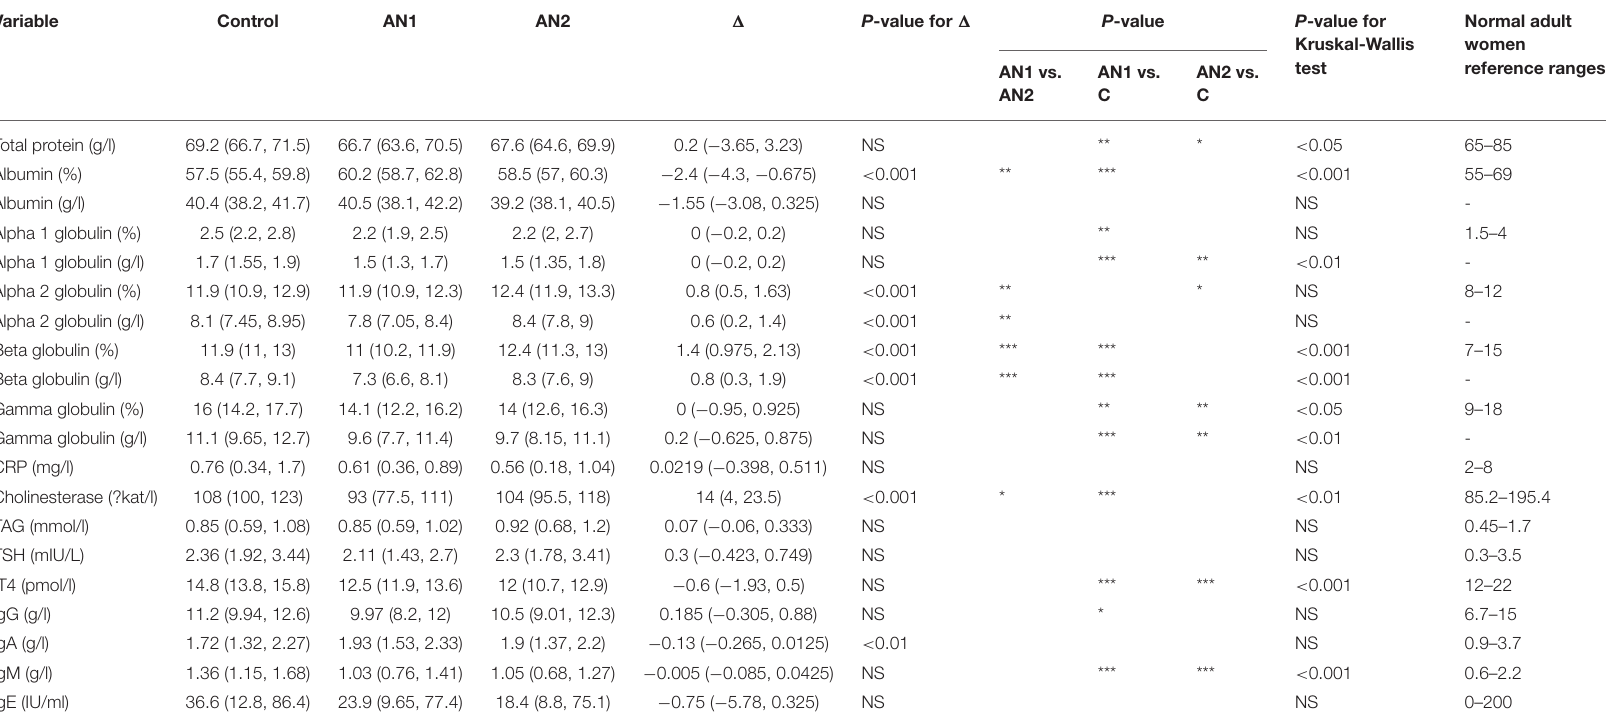
CRP, C-reactive protein; TAG, triacylglycerols; TSH, thyroid-stimulating hormone; fT4, thyroxine. Changes during hospitalization (calculated as the values at hospital admission and values at hospital discharge) were evaluated by Wilcoxon’s paired test corrected for ties. The multiple comparisons between groups were evaluated by the Kruskal-Wallis Z test followed Dunn’s multiple comparisons with Bonferonni correction. Both Kruskal-Wallis test and Wilcoxon’s test were corrected for multiplicity using Bonferroni correction. The results are shown as median with quartiles. AN1—patients with anorexia nervosa before treatment, AN2—patients with anorexia nervosa after treatment; 1 represents the absolute change calculated as the value after intervention - basal value; nControl = 67, nAN1 = 52, nAN2 = 52; * p < 0.05, ** p < 0.01, *** p < 0.001. NS,